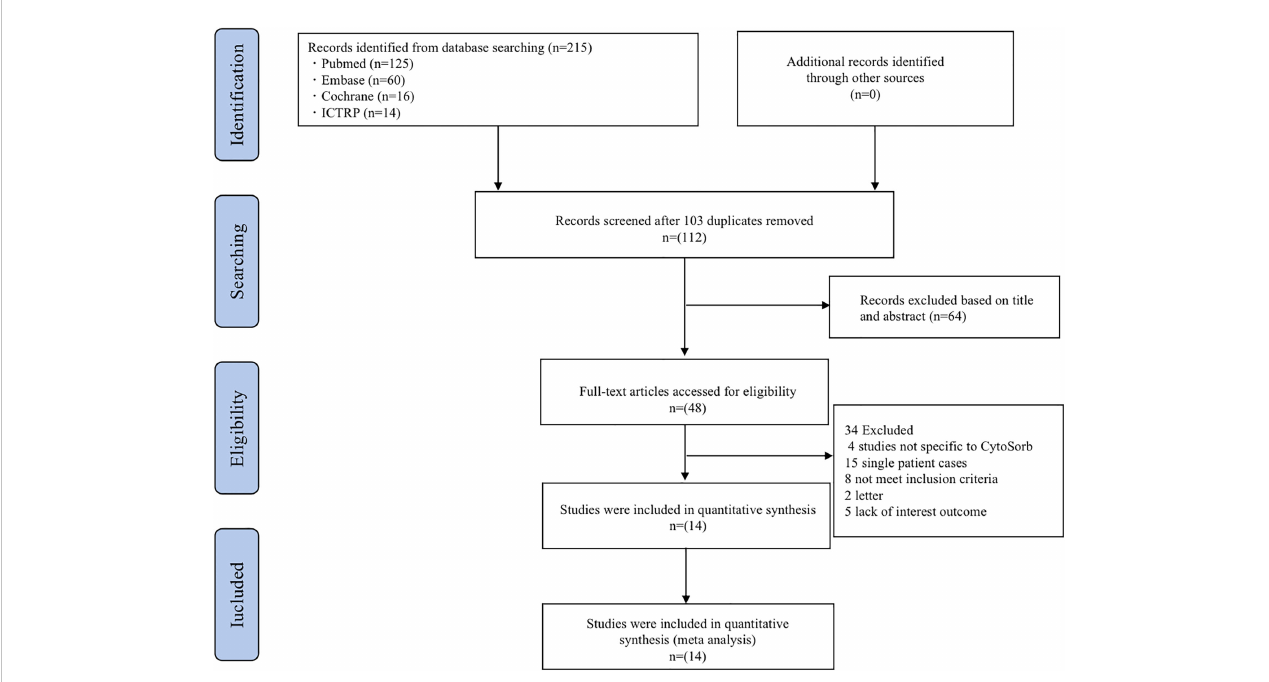
FIGURE 1 Flow diagram of the study selection process. ICTRP, the International Clinical Trials Registry Platform.